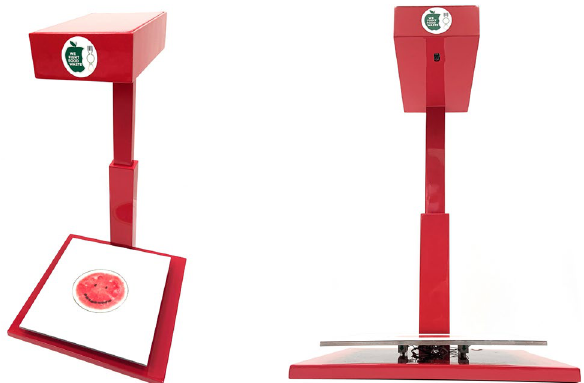
Figure 10. A prototype of an integrated plate waste tracker. It consists of load cells at the bottom to measure the weight of plate waste, and a camera at the top to capture an image of the plate waste before disposal, both of which are controlled by a ‘Raspberry Pi’ running a Python program.